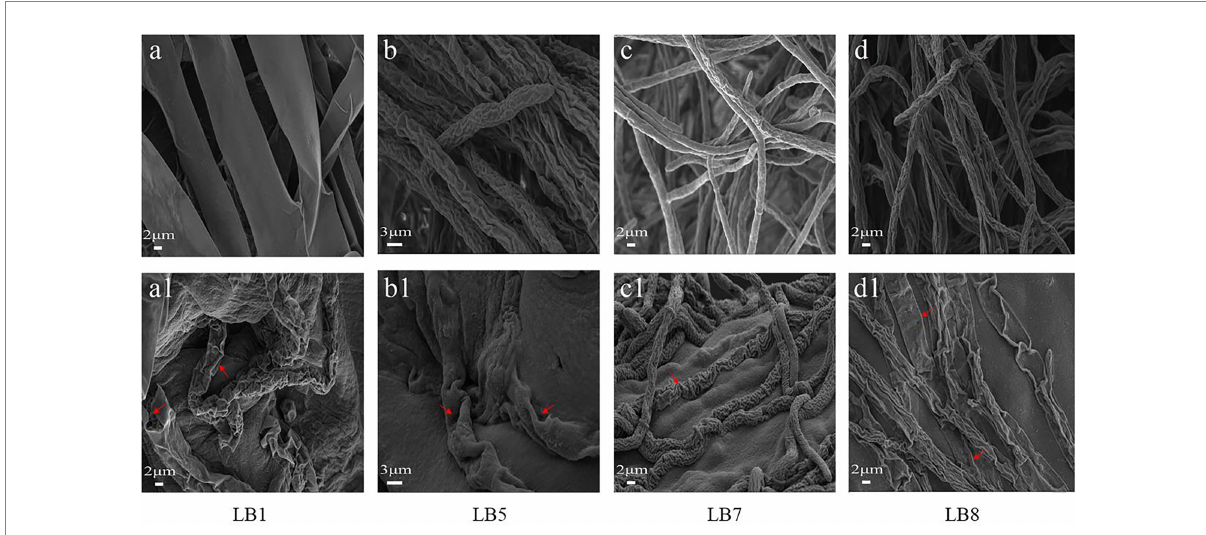
FIGURE 3 Scanning electron microscopy observation of mycelial morphology ( A–D : control group, A1–D1 : treatment group with 2,3-butanedione).